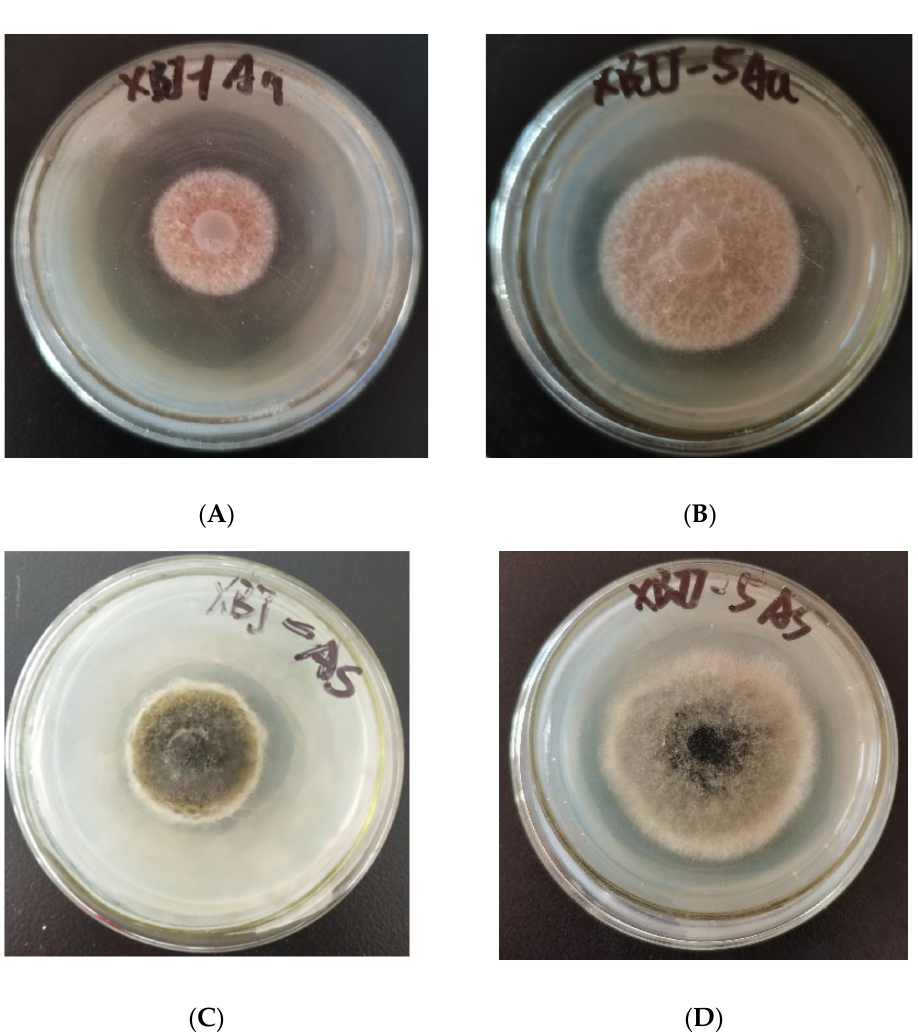
Figure 1. In vitro inhibition of mycelial growth of A. Alternata and A. Salani by compounds 3n and 4n . ( A ) 3n at 200 μ g/mL for A. Alternata; ( B ) 4n at 200 μ g/mL for A. Alternata; ( C ) 3n at 200 μ g/mL for A. Salani; ( D ) 4n at 200 μ g/mL for A. Salani .